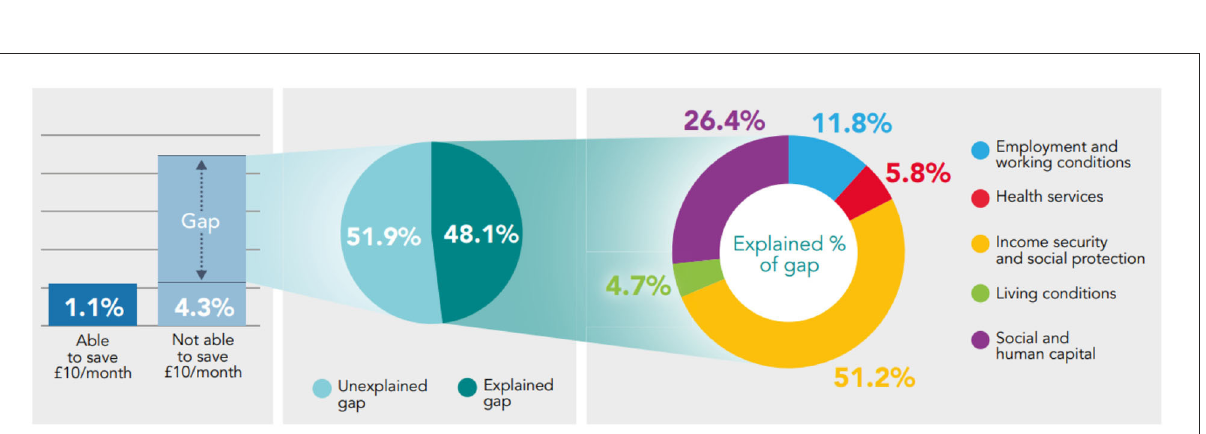
FIGURE3 Decomposing the gap in prevalence of low life satisfaction between those who are able to make a saving of at least £10/month, and those who are not using the Binder-Oaxaca methodology, non-pensioner adults (aged 16–65), Wales, 2016–17 to 2019–20.